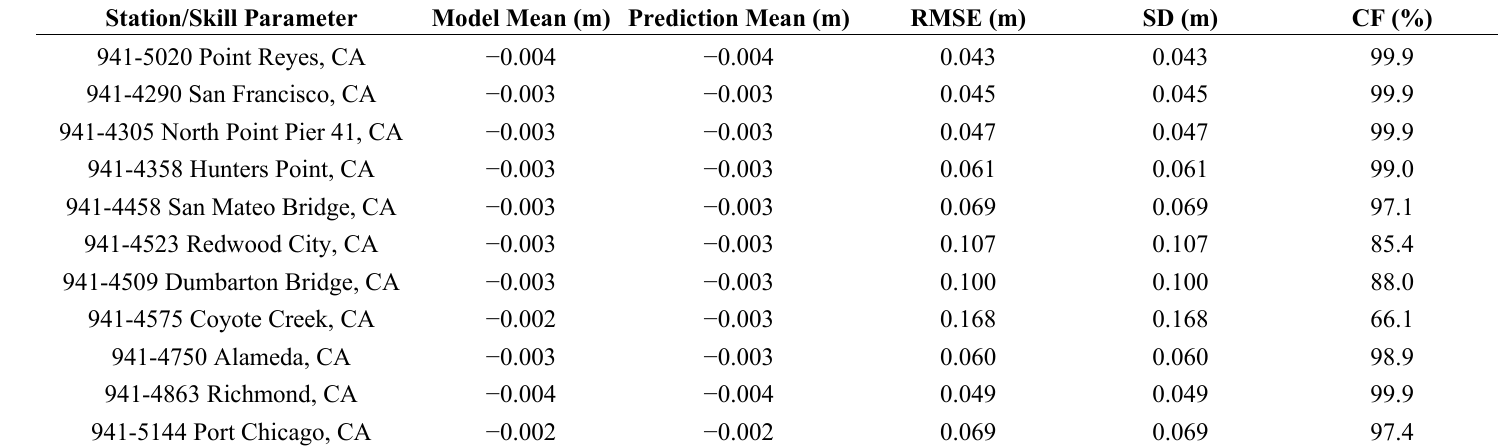
Table 7. Nineteen-month Tidal Simulation Water Level Skill Assessment Results. Results are with respect to MSL. RMSE is root mean square error, SD is standard deviation of the error; e.g., model minus observation, and CF is central frequency of the errors with respect to a reference level of 0.15 m.